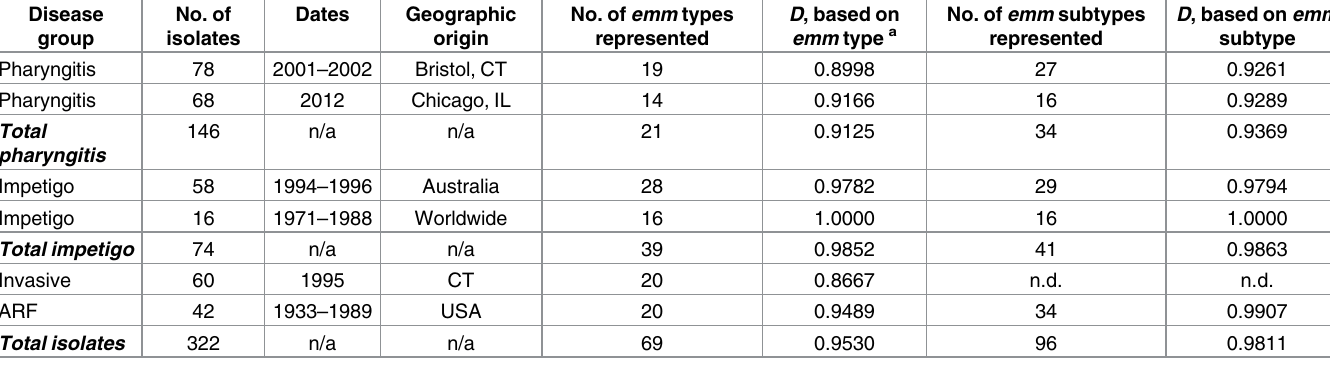
Table 1. Characteristics and diversity of GAS isolates under analysis. Disease